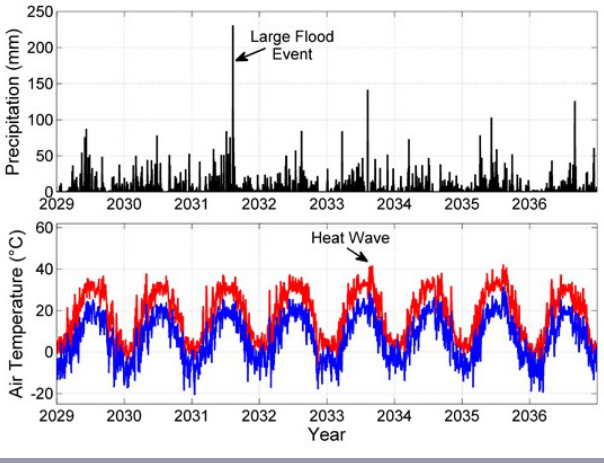
Fig. 10. Maps of land cover for 2010 (upper left) and each scenario in 2070. Grassland and other natural land covers replace low-intensity urban land and agricultural land in “Abandonment and renewal”. Urbanization increases substantially in “Accelerated innovation” as population increases and the smaller agricultural land base is